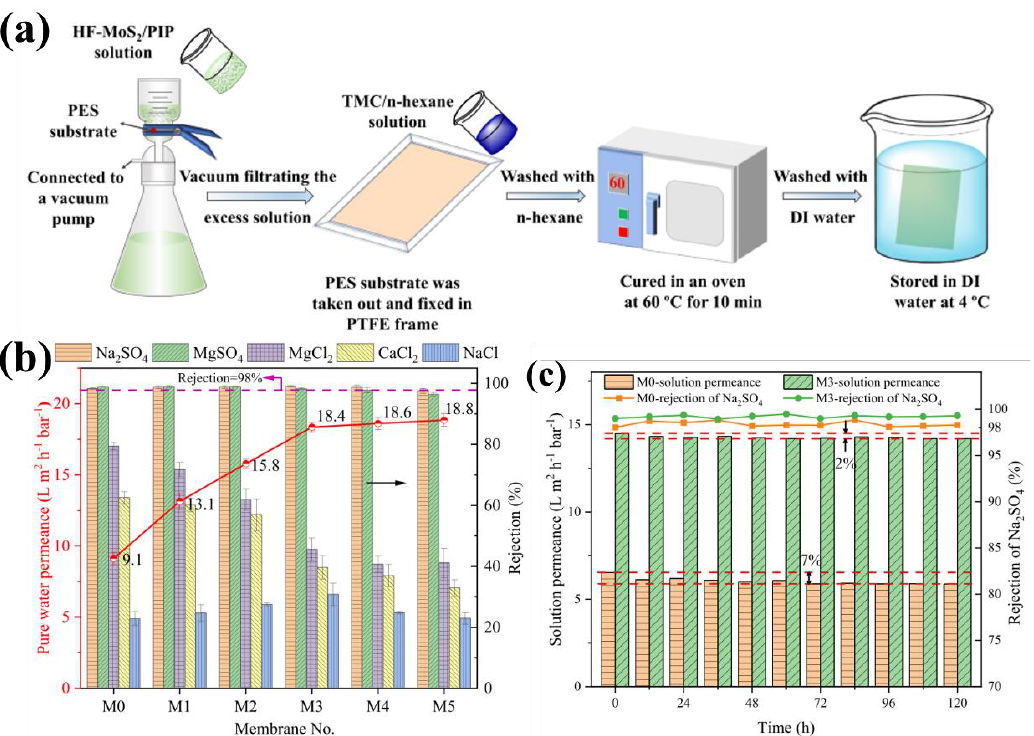
Figure 4. ( a ) The schematic diagram of TFNi membrane fabrication with the MoS 2 interlayer; ( b ) NF separation performance of prepared TFNi membranes, and the deposition density (0, 2.5, 5.0, 10, 15, and 20 μg/cm 2 ) of MoS 2 nanosheets were denoted as M0, M1, M2, M3, M4, and M5; ( c ) a long-time stability test of TFNi membranes (M0 and M3) within 120 h, reproduced with permission from Wang et al. [72], with copyright permission from © 2022 Elsevier.